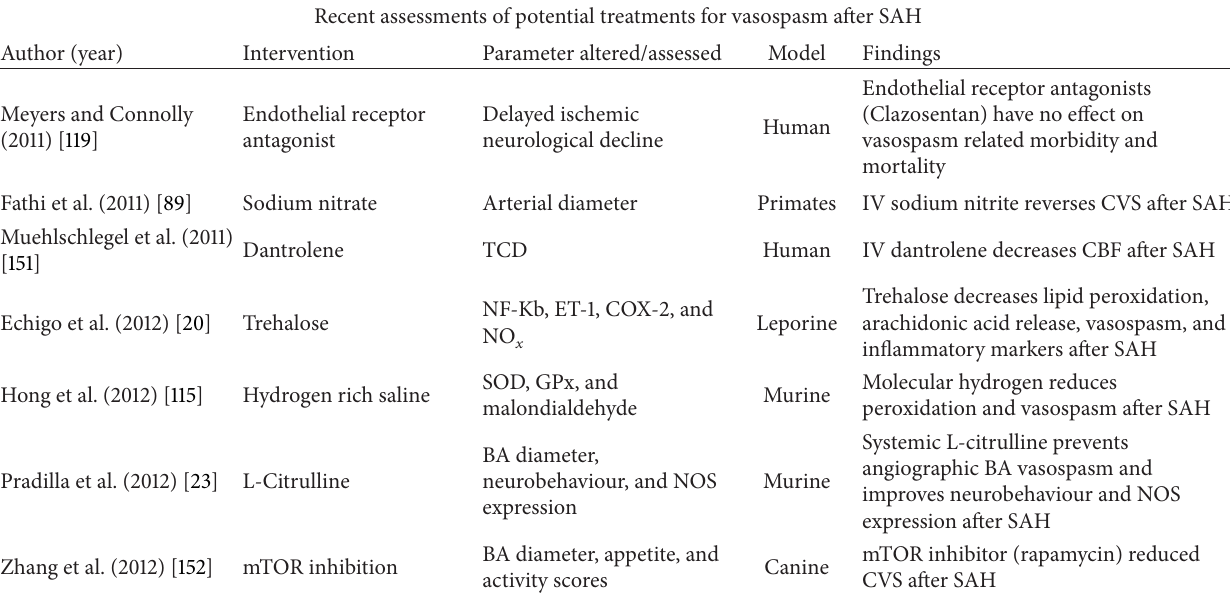
Table 3: Recent studies have shown improvements in clinical and experimental vasospasm with the use of other various pharmacological